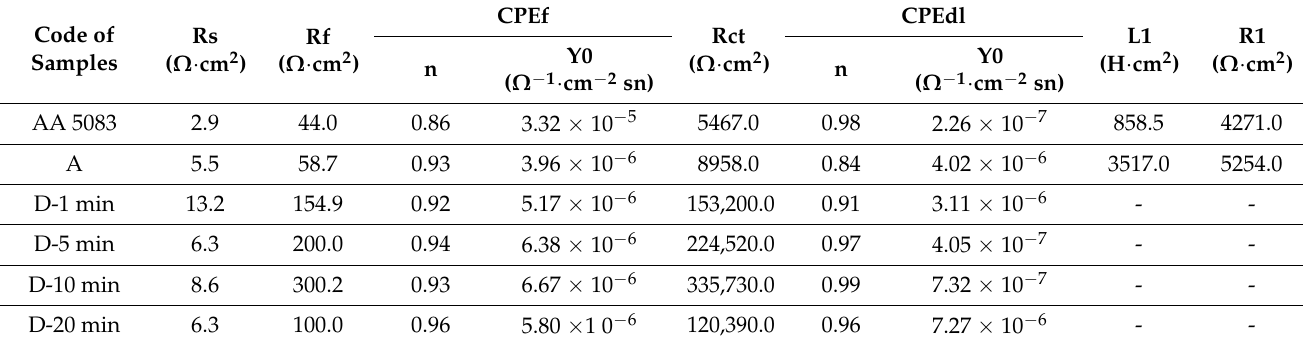
Table 6. Obtained fit data of EIS diagram of assessing the effect of deposition time in D Pretreatment Method. Code of Samples